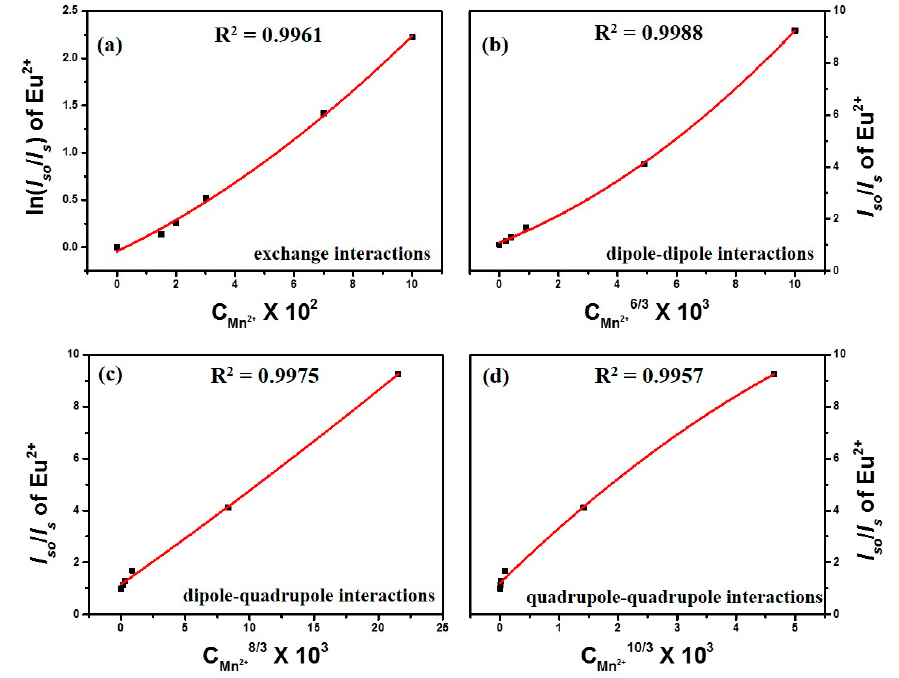
Figure 5. ( a ) Dependence of ln( I S0 / I S ) of Eu 2+ on C Mn2+ ; and of I S0 / I S of Eu 2+ on ( b ) C Mn2+6/3 ; ( c ) C Mn2+8/3 ; ( d ) C Mn2+10/3 .